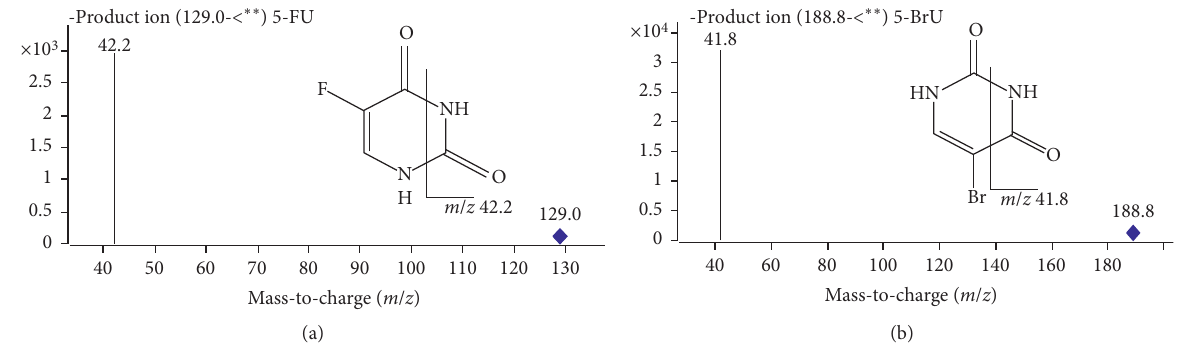
Figure 1: Product ions chromatograms and fragment structures of 5-FU (a) and 5-BrU (b). Table 1: Mass spectrometric parameters of analyte and internal standard